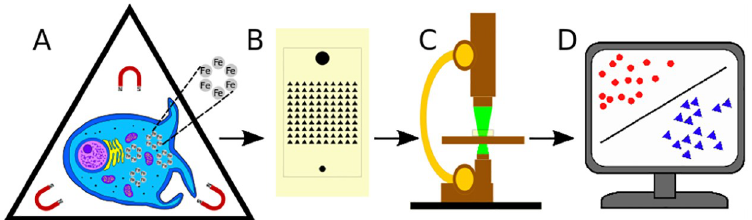
Fig 1. A schematic summary of the cell morphodynamics protocol. A: A captured cell expresses its morphodynamic phenotype while being gently rotated in a magnetic field, enabled by endocytosis of magnetic nanoparticles. B: The microfluidic device contains an array of triangular microwells designed so as to capture individual cells, in spaces large enough for cells to rotate freely. C: Rotating cells are fluorescently imaged on an environmentally controlled microscope stage. D: Cell images are converted by CellProfiler into parameters, used by Machine Learning algorithms to provide cellular clustering, classification, and analysis.